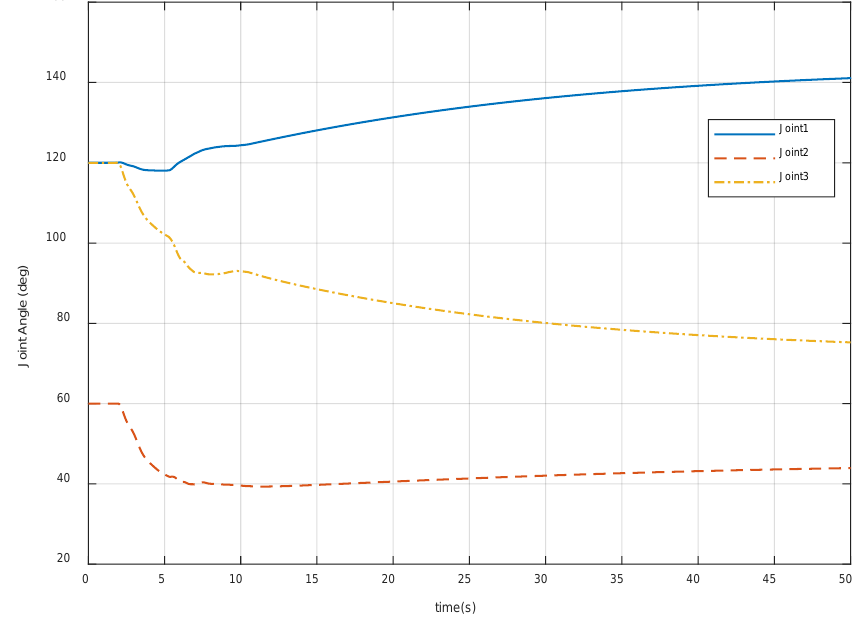
Figure 18. Variation of the manipulator joint angles.